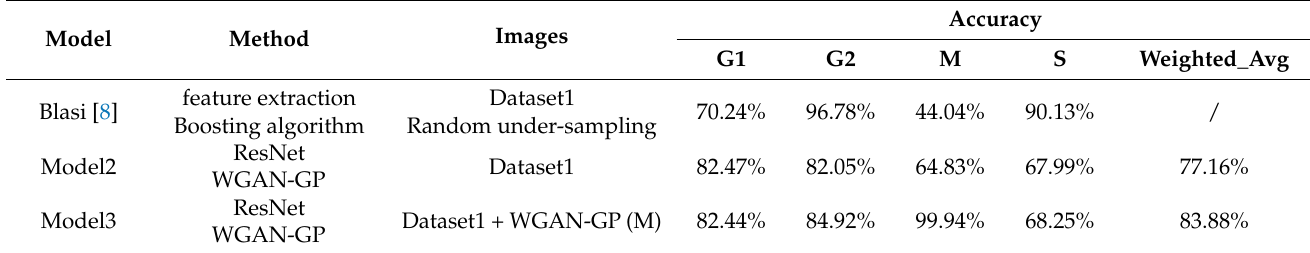
Table 11. The four-stage classification accuracy on the same dataset (Jurkat datasets).